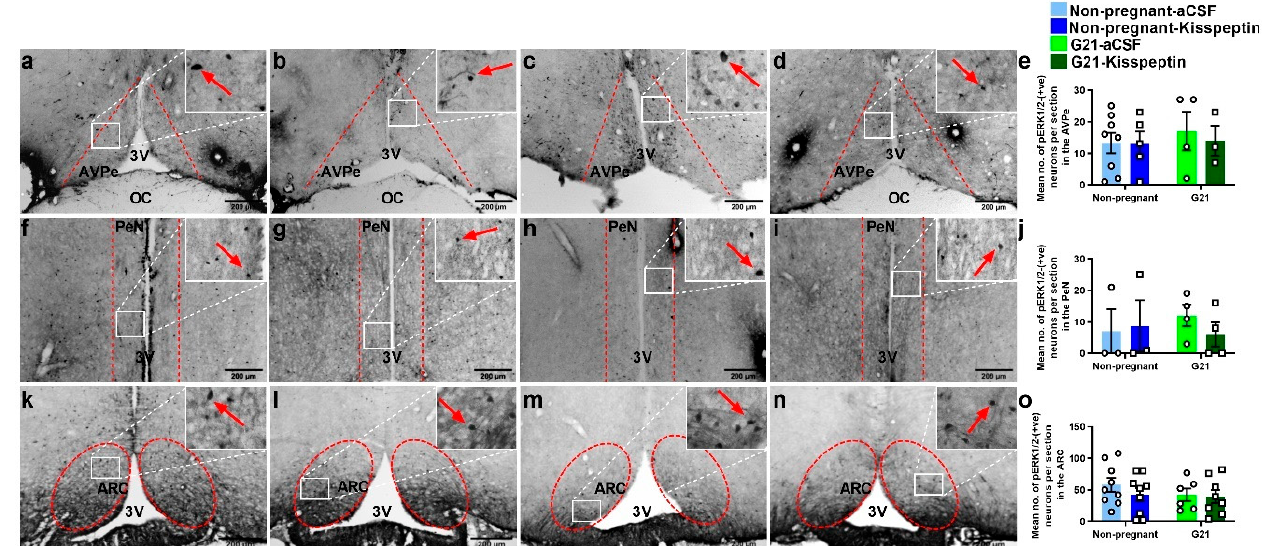
Figure 9. Kisspeptin does not affect pERK1/2 expression in AVPe, PeN or ARC neurons of non- pregnant and G21 rats. Photomicrographs of coronal sections containing AVPe ( a – d ), PeN ( f – i ) and ARC ( k – n ), within the red dotted area, showing pERK1/2-positive neurons in non-pregnant rats ( a , b , f , g , k , l ) and G21 rats ( c , d , h , i , m , n ) after ICV administration of aCSF ( a , c , f , h , k , m ) or kisspeptin (2 µg in 2 µL; b , d , g , i , l , n ). Red arrows point to representative pERK1/2 labelling. Mean (± SEM) number pERK1/2-positive neurons per section in the ( e ) AVPe (RS: F (1,1) = 0.270, p = 0.609; T: F (1,1) = 0.126, p = 0.726; RS × xT: F (1,2) = 0.090, p = 0.767, two-way ANOVA) of non-pregnant (aCSF-treated, n = 8,